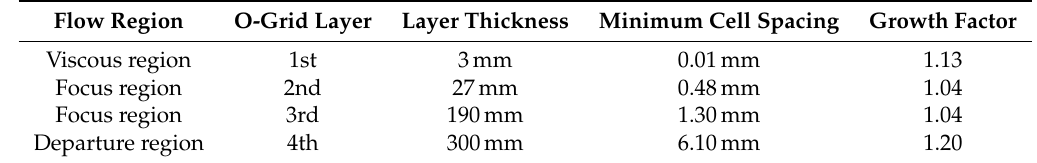
Table 2. Wall-normal grid